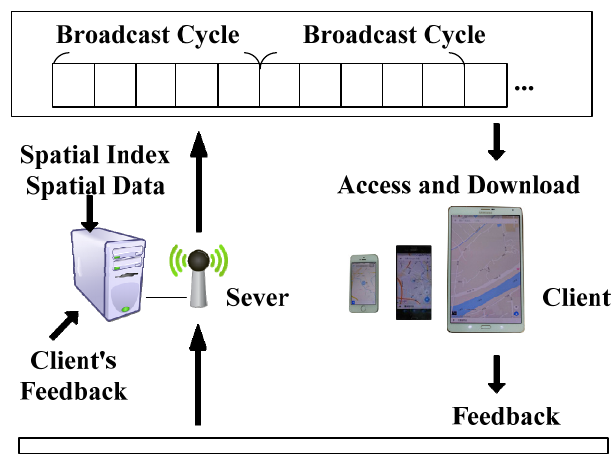
Figure 1. The system model used in the proposed method.